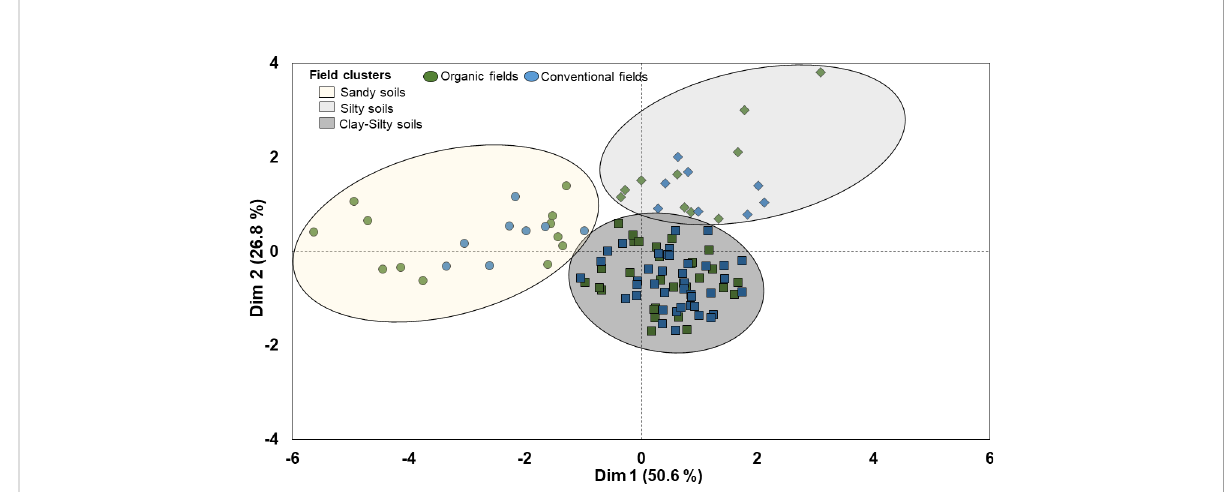
FIGURE 3 Cluster analysis for 110 organic and conventional faba bean fi elds based on their similarities in soil abiotic properties.